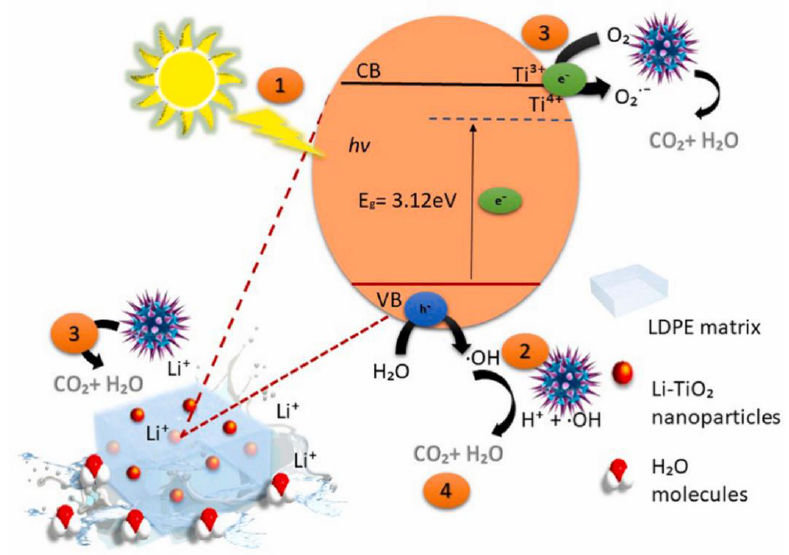
Figure 5. The antimicrobial mechanism of the heterostructured nanocomposites of Li-TiO 2 /LDPE against S. aureus . Abbreviation: valence band: VB; conduction band: CB. Reproduced with permission from ref. [83]. Copyright © 2019, Elsevier.